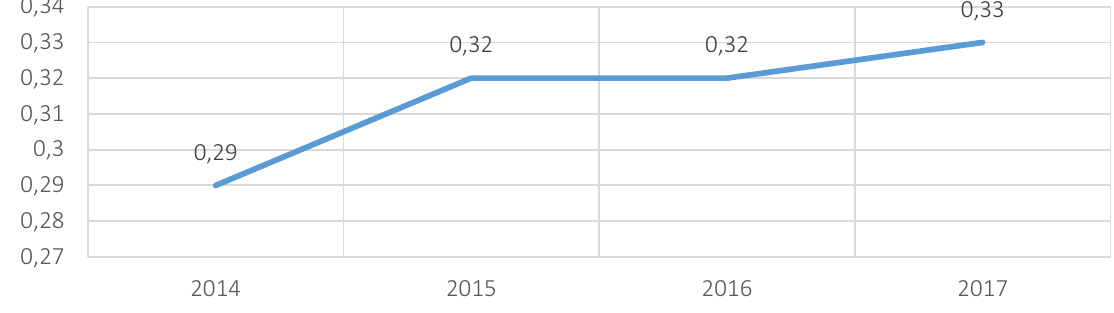
Figure 3. Results of calculations of the concentration coefficient for 2014–2017, %